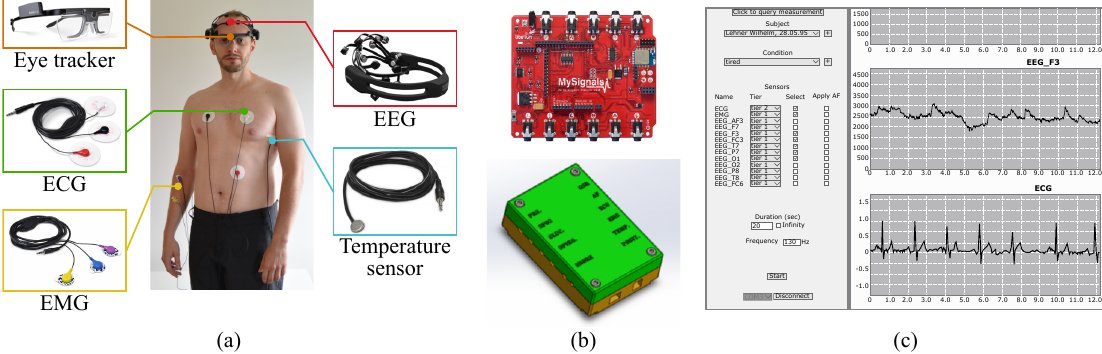
Figure 2. Sensor setup. ( a ) Selected sensors and how to wear them. ( b ) MySignals Arduino shield and protective case. ( c ) Data acquisition application implemented in